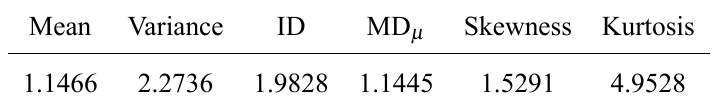
Summary Statistics of